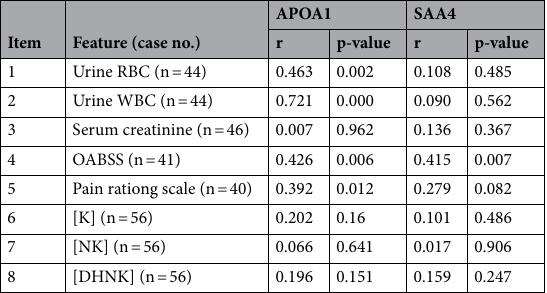
Table 4. Correlations among clinicopathological features, APOA1 and SAA4 urine levels in 56 KA.